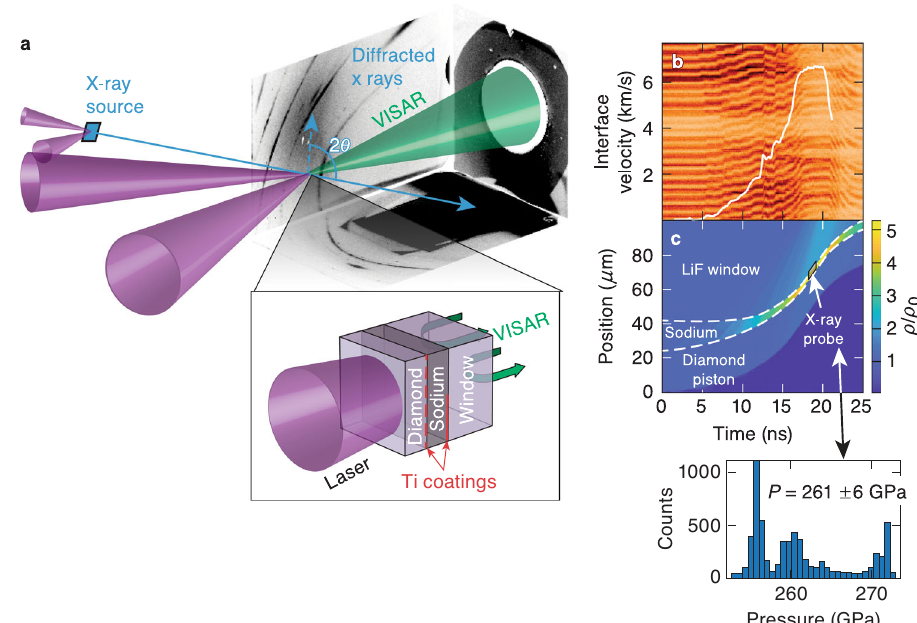
Fig. 2 Experimental con fi guration. a The experimental setup for simultaneous X-ray diffraction and re fl ectivity measurements using LiF or MgO windows. b Example velocimetry data and the corresponding Na – LiF interface velocity (shot 27967). c A simulated space-time map of the compression, ρ / ρ 0 , and the pressure histogram in the Na sample during the X-ray probe (shot 27967).